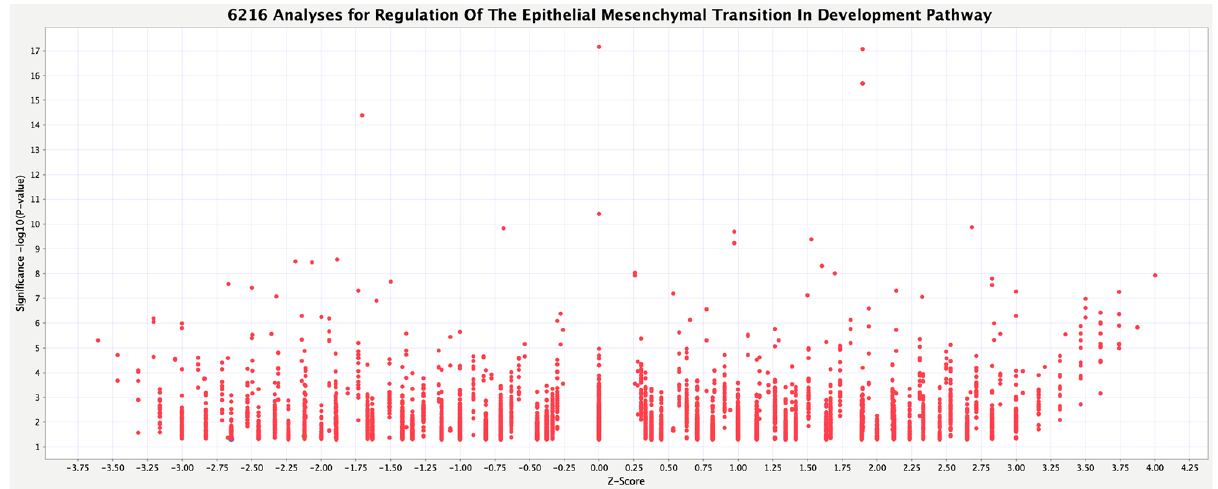
Figure 3. Activity plot of regulation of EMT in development pathway (6216 analyses, as of September 2021).